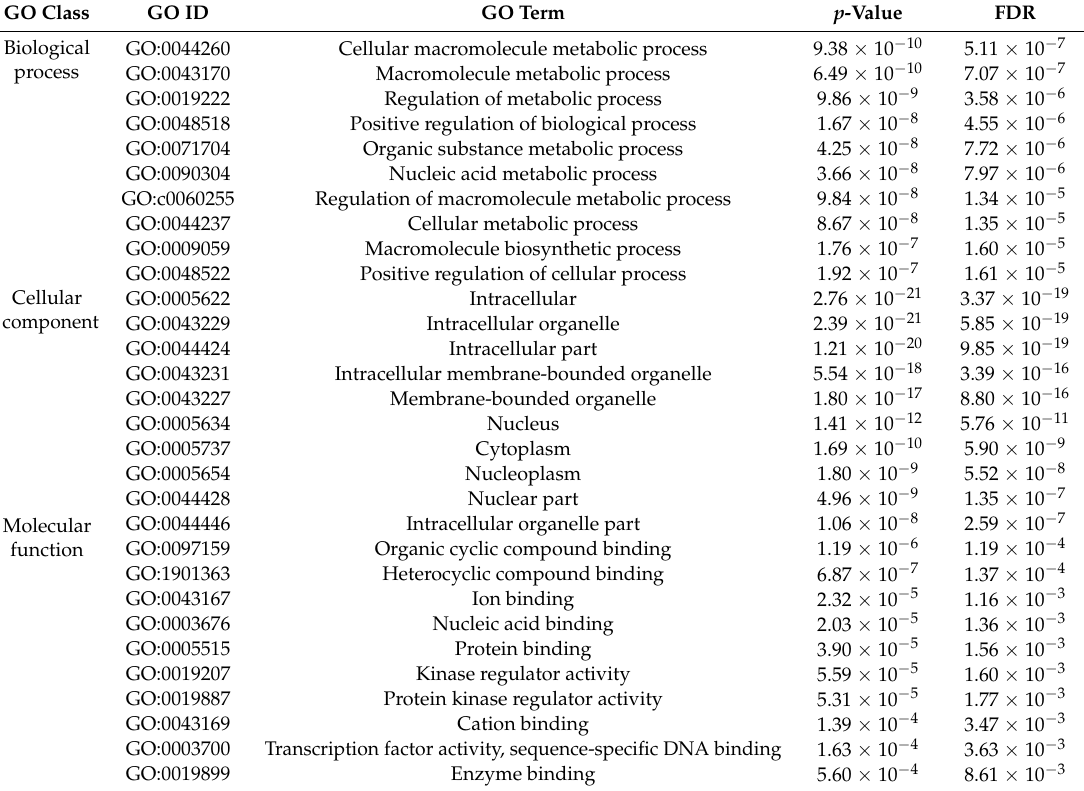
Table 5. Most significantly enriched gene ontology (GO) terms for target genes of differentially expressed